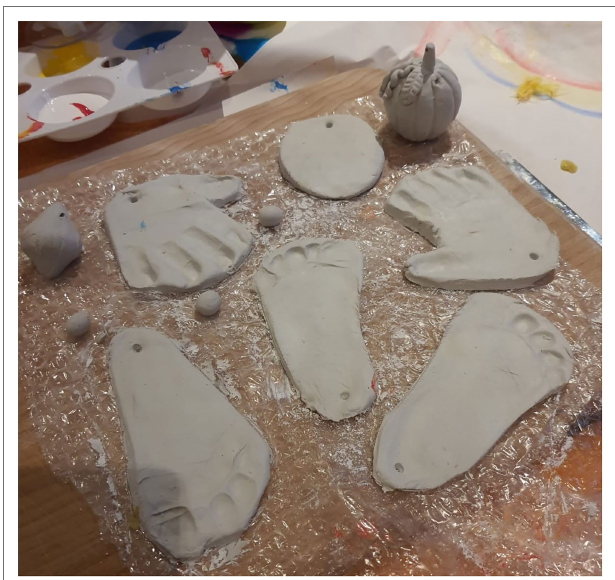
FIGURE 11 | Final art work, hand and foot